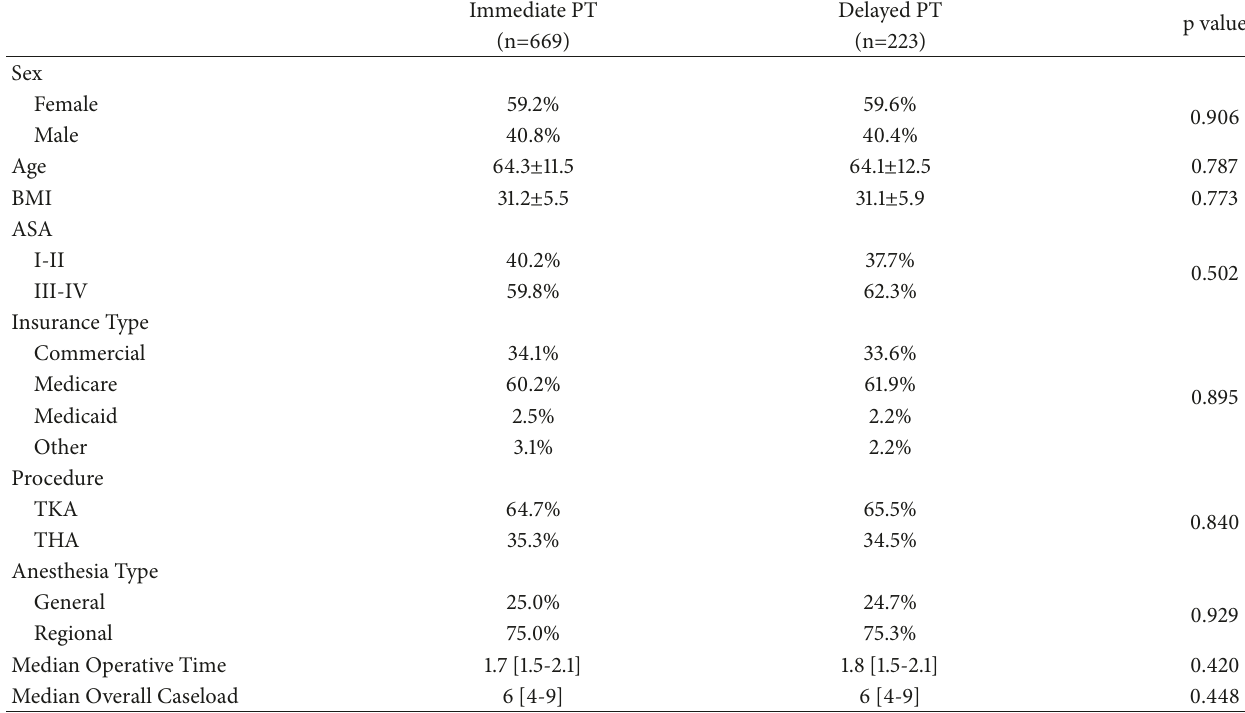
Table 3: Demographic and perioperative variables for matched immediate and delayed PT groups.